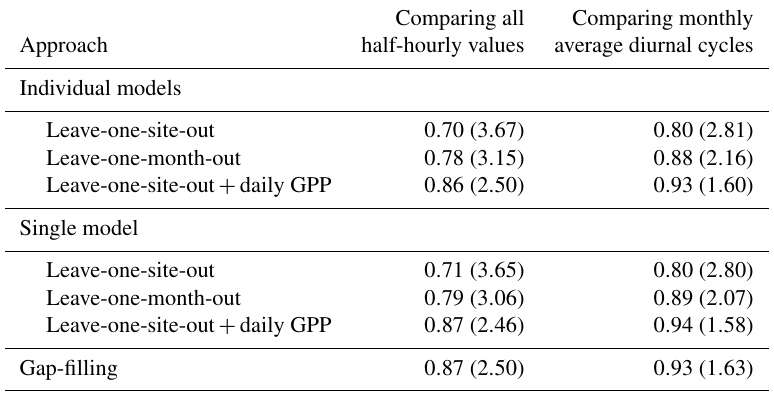
Table 2. Comparing modeling efficiencies (and RMSE in µmolm − 2 s − 1 ) of the two auxiliary experiments (leave-one-month-out setup and including the daily GPP as an additional predictor in the leave-one-site-out setup) to the best performances obtained with the leave-one-site- out experiments by using daily predictor variables, half-hourly potential radiation, and half-hourly meteorological